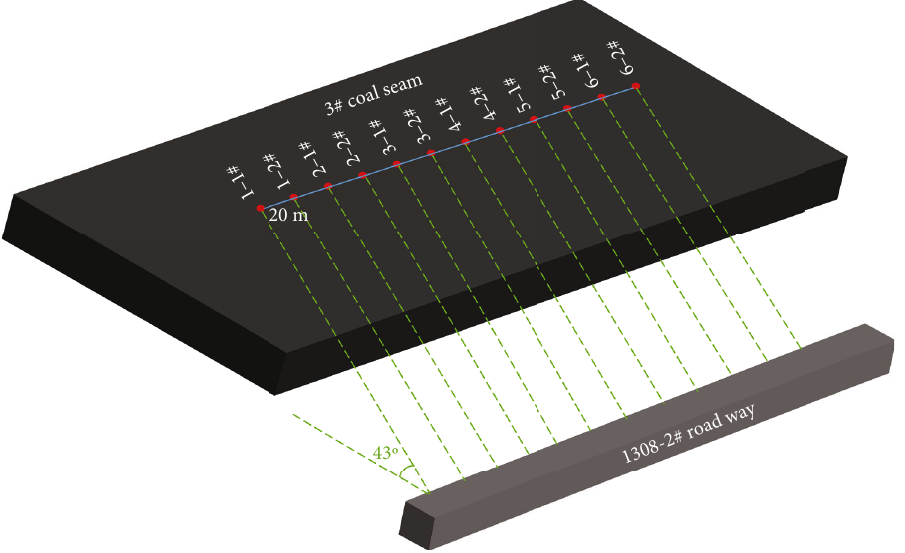
Figure 2: Layout of boreholes in the fi rst test